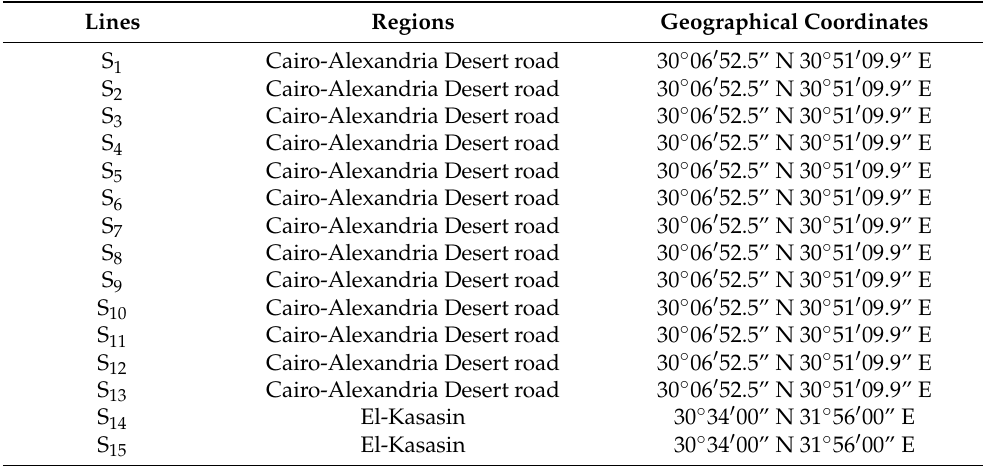
Table 4. Regions and geographical coordinates of the Egyptian elite jojoba lines. Lines Regions Geographical